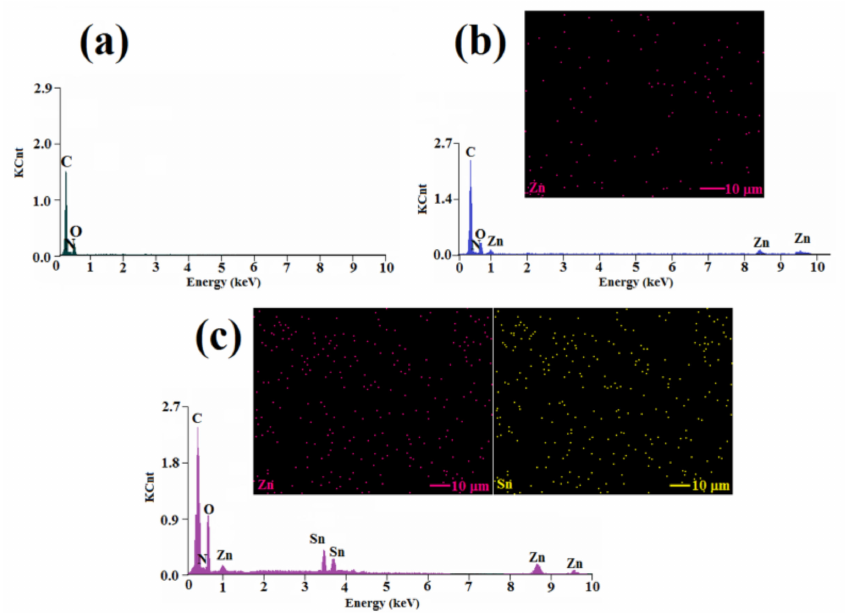
Figure 8. EDX analysis results for L1 ( a ) and the mapping images registered for L2 ( b ) and L3 ( c )